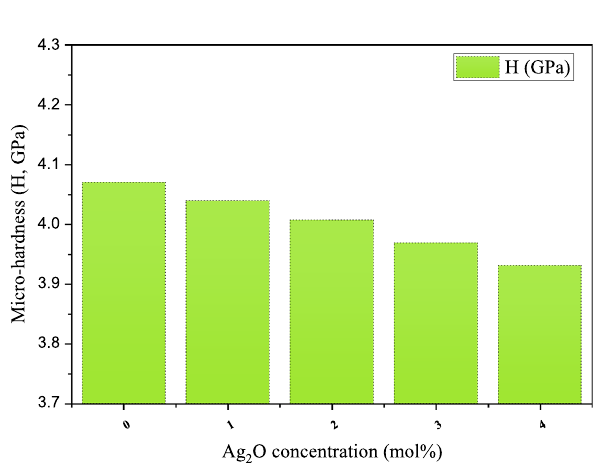
Table 2. The mechanical properties of the fabricated BBSNAg glass samples.